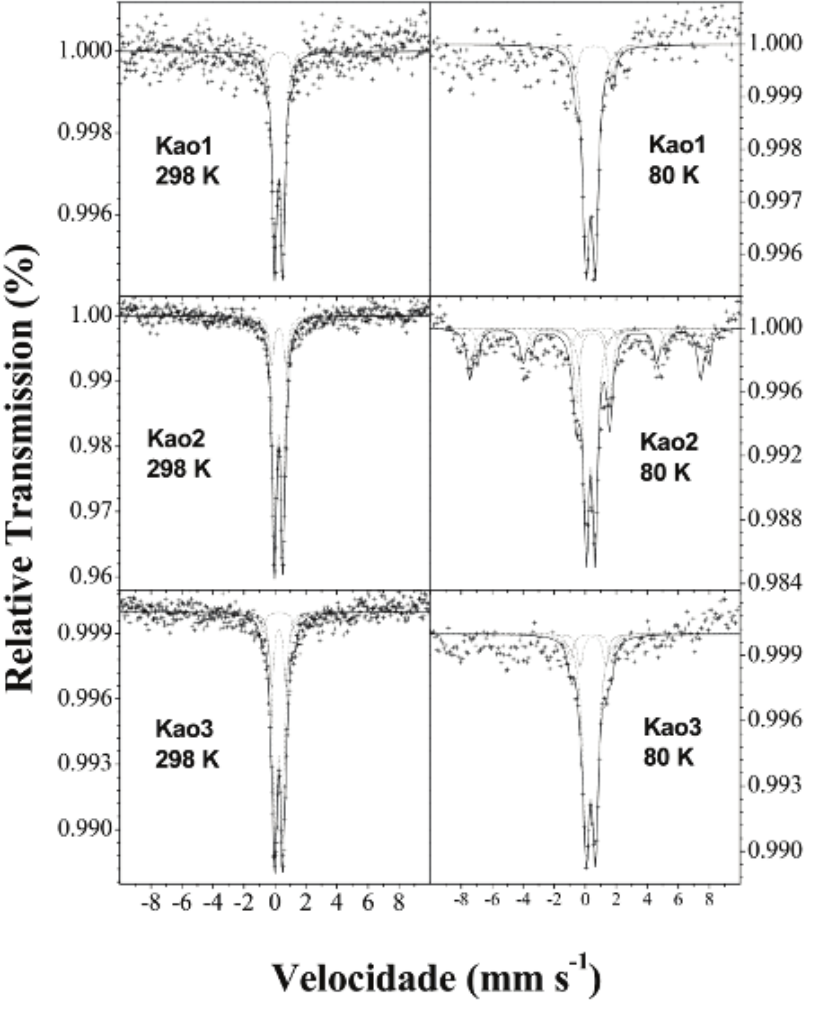
Figure 4 - Mössbauer spectra at 298K and 80K of the